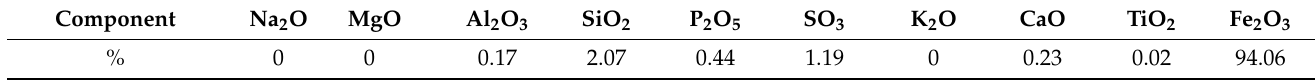
Table 4. Sediment XRF tests.